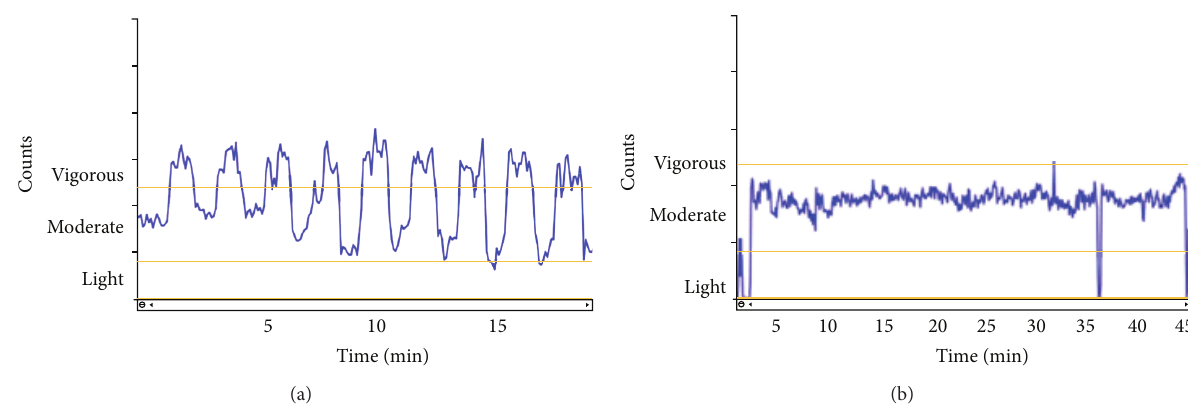
Figure 2: (a) Representative accelerometer counts recorded throughout a bout of HIIT during the intervention. Note: nine intervals were completed in this training session. (b) Representative accelerometer counts recorded throughout a bout of MICT during the intervention. Note: approximately 45 minutes of MICT was completed in this training